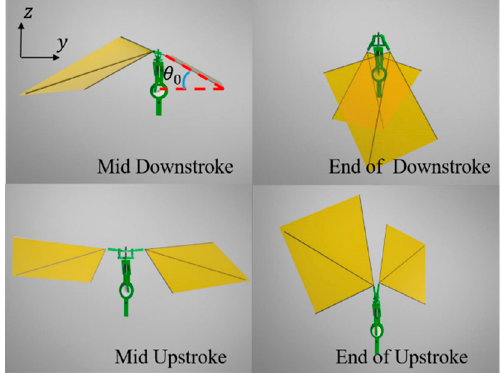
Figure 6. Trace line of the flapping wing rotor.